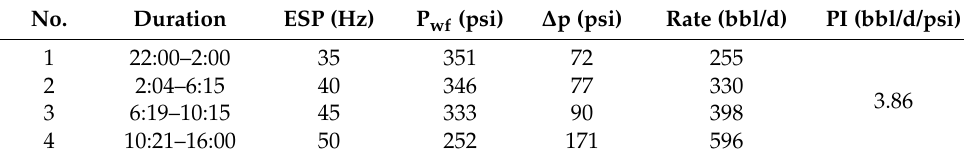
Table 5. Test production data of MIS A.